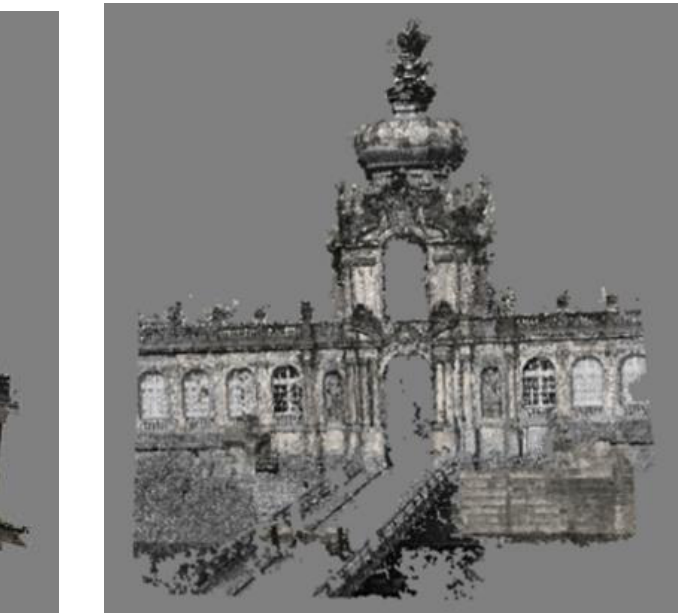
Figure 8. Camera positions of the historical (dark blue) and the current (light blue) images